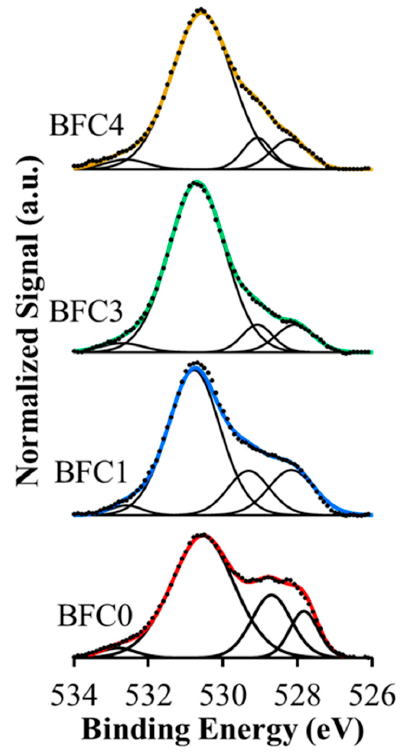
Figure 5. XPS spectra for O 1s transition